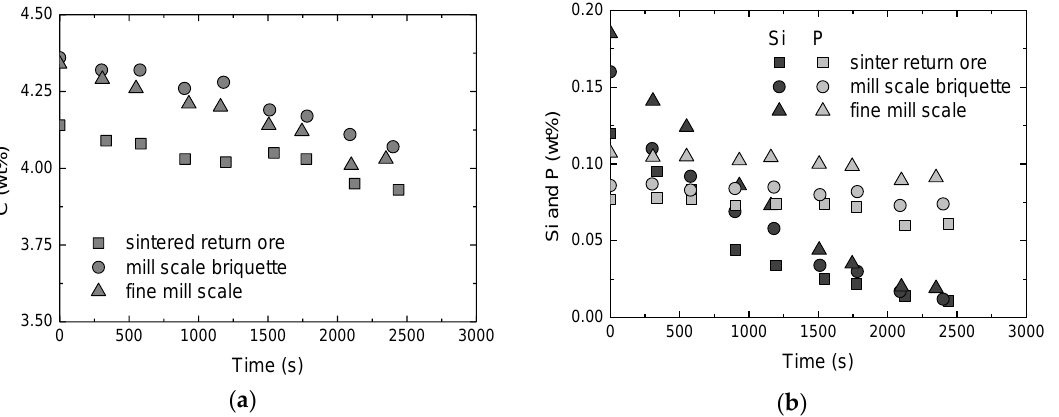
Figure 3. Changes in ( a ) C and ( b ) Si/P contents of hot metal upon addition of various solid oxygen materials. oxygen